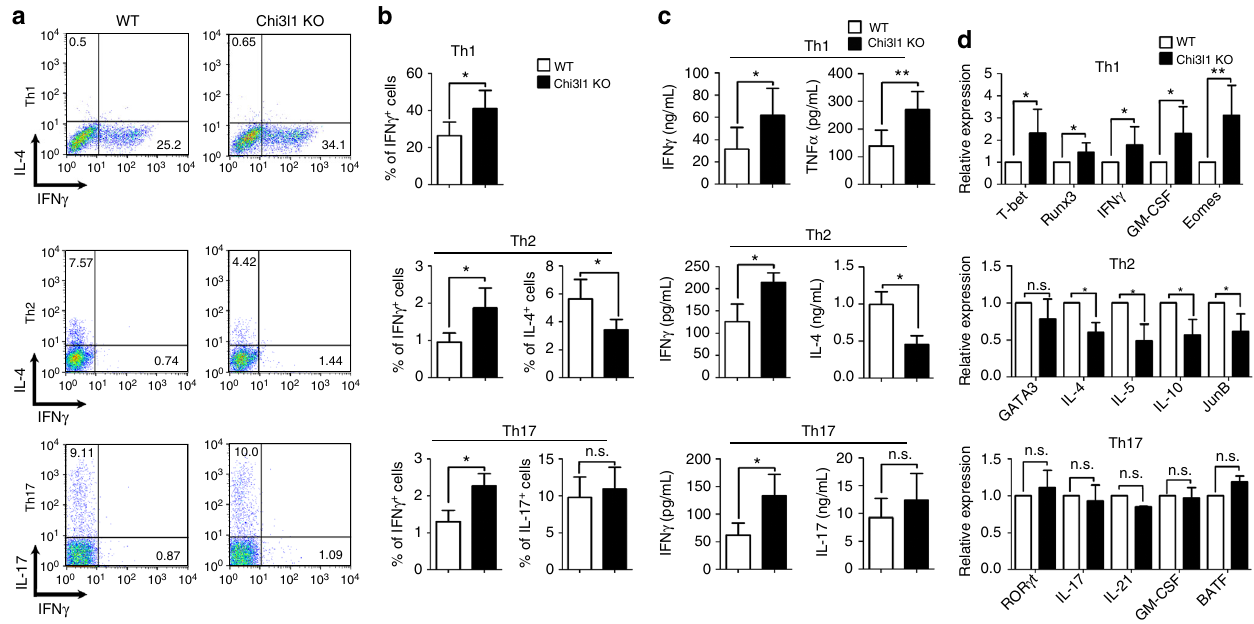
Fig. 3 Chi3l1 KO CD4 T cells are prone to Th1 differentiation. a , b MACS-sorted WT and Chi3l1 KO naive CD4 T cells were differentiated into Th1, Th2, and Th17 cells under speci fi c cytokine-skewing condition, and Intracellular cytokine staining performed to analyze lineage-speci fi c cytokine expression. c IFN γ , TNF α , IL-4, and IL-17 production in culture supernatants were measured by ELISA. d Lineage speci fi c mRNA levels were analyzed by quantitative RT-PCR. Each gene expression level was normalized to β -actin, and represented as relative expression to WT. Data are mean ± SD of eight sets of independent experiments ( n = 16). n.s., not signi fi cant; * p < 0.05, ** p < 0.01 (two-tailed Student ’ s t